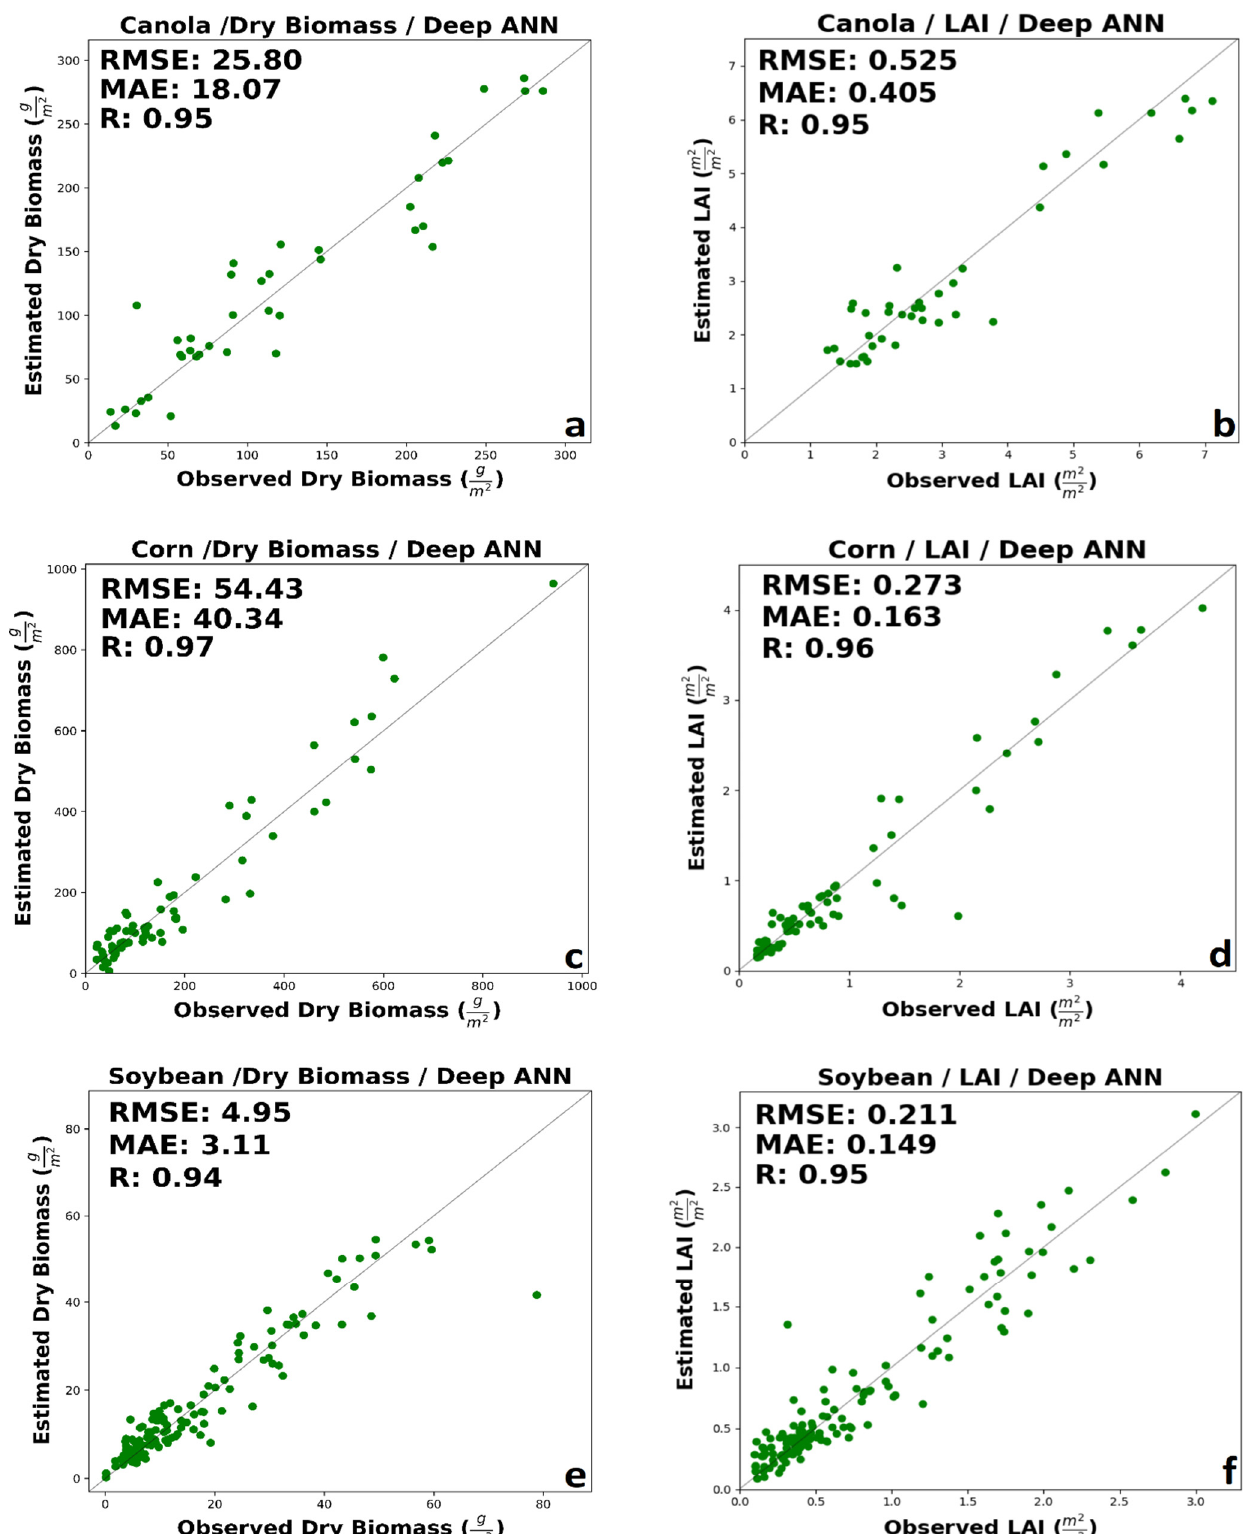
Figure 6. The results of Deep ANN for ( a ) canola’s dry biomass, ( b ) canola’s LAI, ( c ) corn’s dry biomass, ( d ) corn’s LAI, ( e ) soybean’s dry biomass, and ( f ) soybean’s LAI. Considering other research works, Reisi-Gahrouei, et al. [44] achieved RMSE of 56.55 g/m 2 and R = 0.72 for canola’s dry biomass using decomposition UAVSAR L-band data.